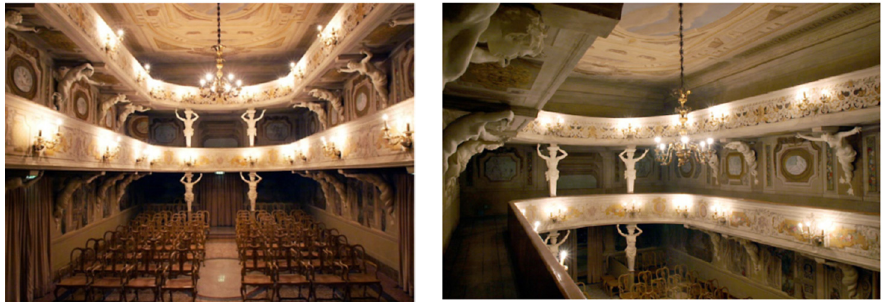
Figure 5. Interior view of the 1763 theatre